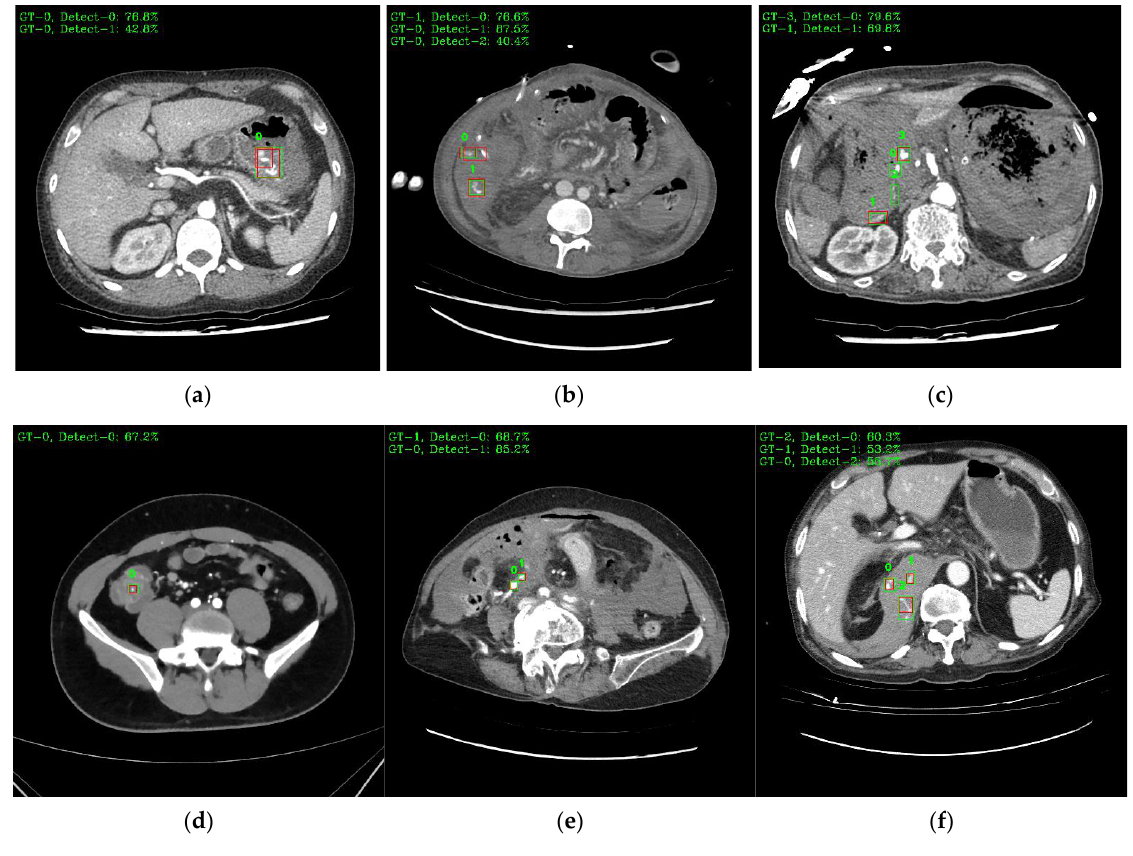
Figure 9. Example images of the AH-lesion detected using the AH detector. Green boxes indicate GT-Box, and red boxes indicate P-Box. Green text is GT-Box index, P-Box index, and IoU score: ( a ) single GT-Box and detected two P-Box; ( b ) two GT-Box and detected each single and two P-Box; ( c ) four GT-Box: detected two P-Box and missed two P-Box; ( d ) single GT-Box: detected single P-Box; ( e ) two GT-Box: detected two P-Box; ( f ) three GT-Box: detected three P-Box.